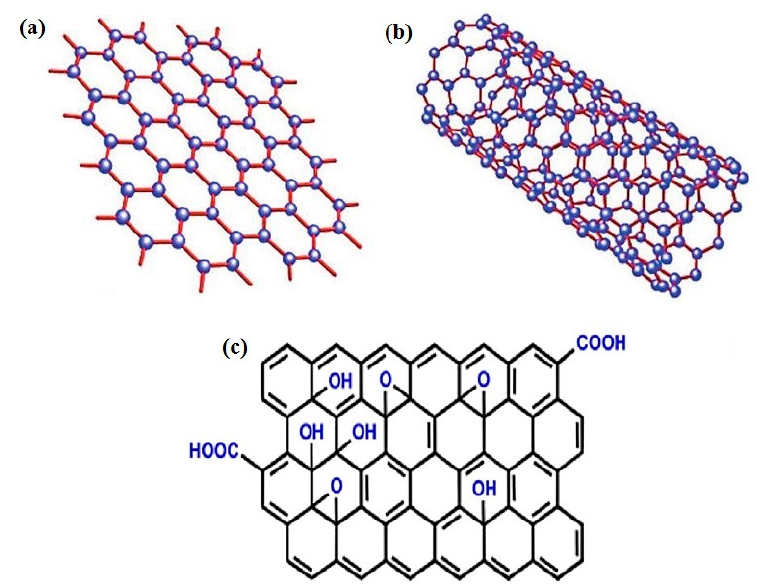
Figure 4. Different types of carbon-based materials, i.e., ( a ) Graphene, ( b ) Carbon nanotube, and ( c ) reduced grapheme oxide, used in electrochemical sensing of H 2 O 2 .